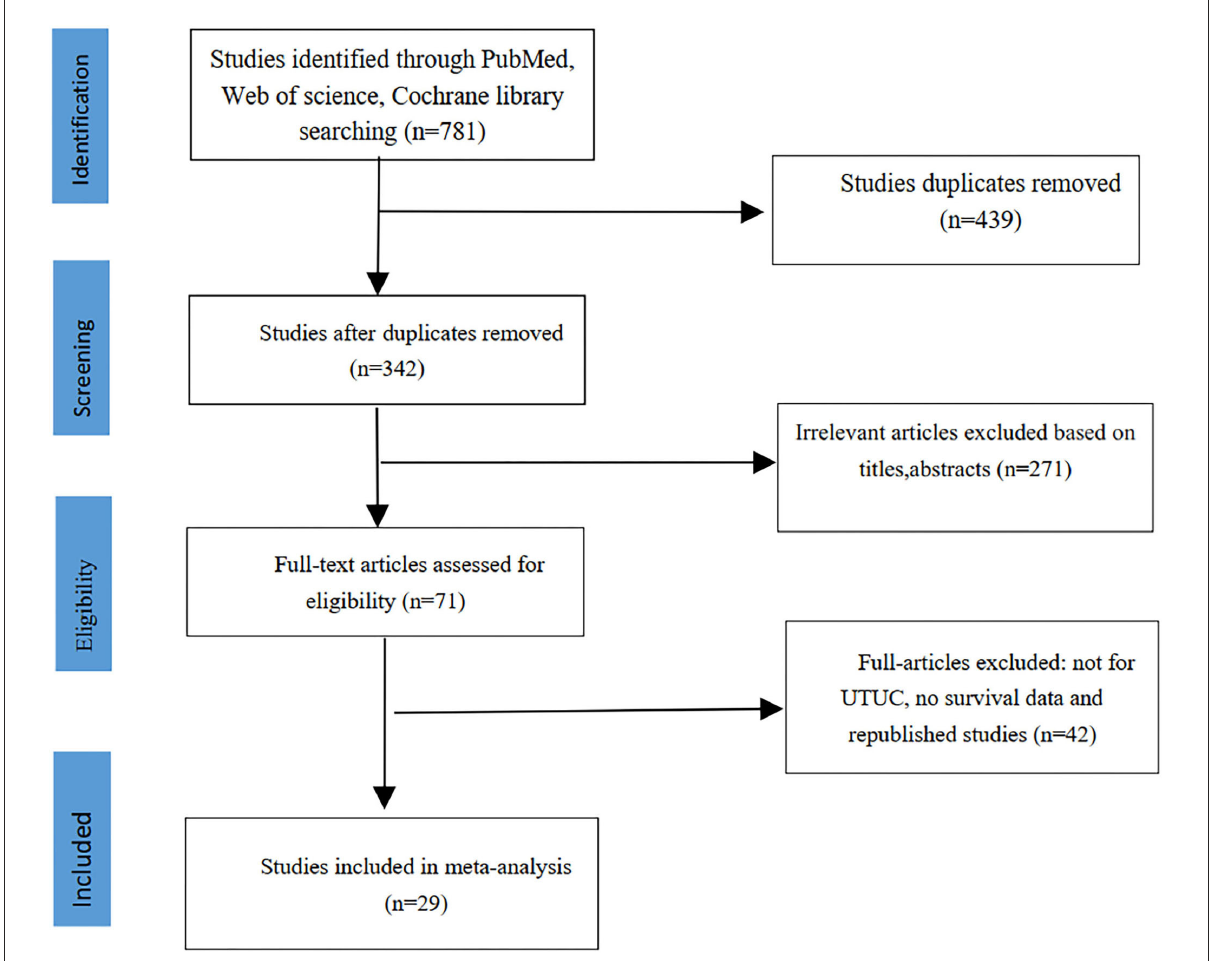
FIGURE1 The flowchart showing study search and selection